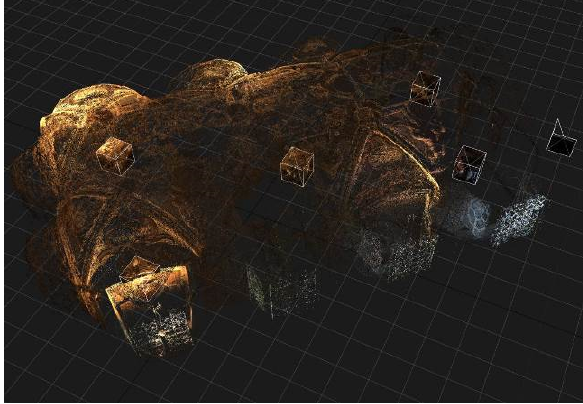
Figure 17. Representation of the scans positions in the Sala Terrena, castle Červený Kameň Figure 18. represented images positions and obtained pointcloud of Sala Terrena in software background.